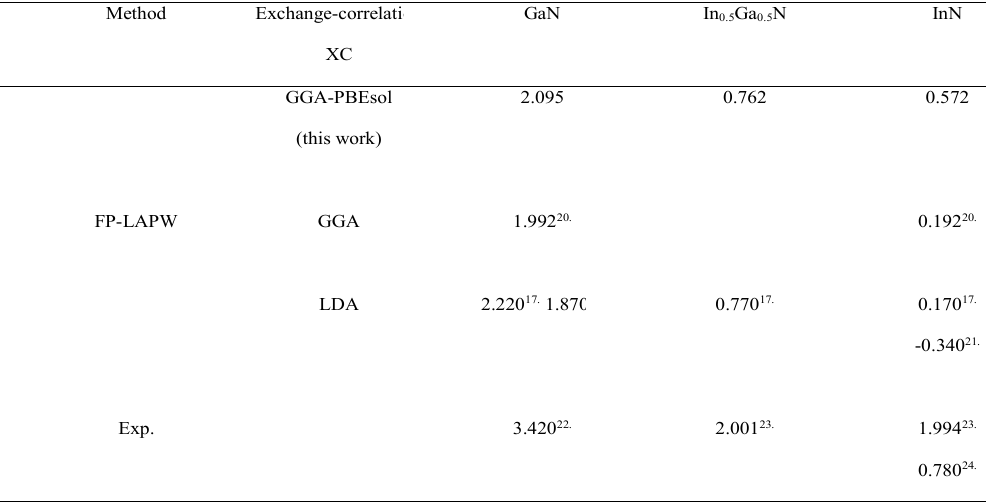
Table 3. The calculated band gaps (eV) in this work (GGA-PBEsol) and some other work in WZ